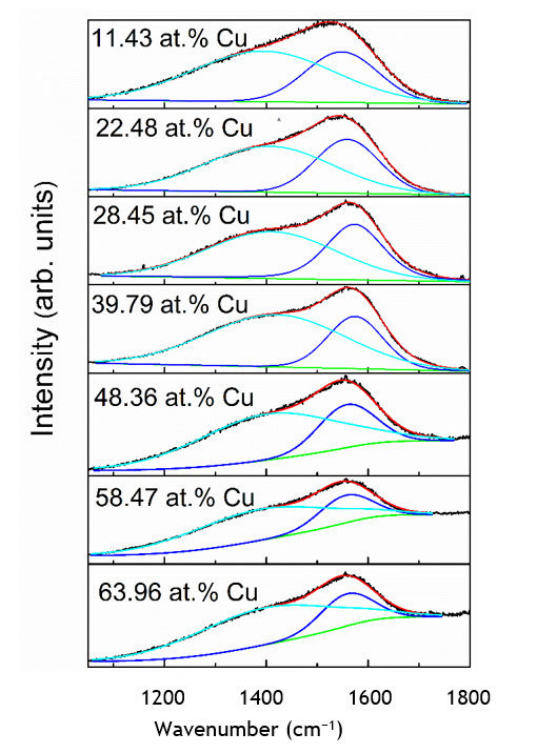
Figure 6. The representative Raman scattering spectra of hydrogen-free DLC:Cu